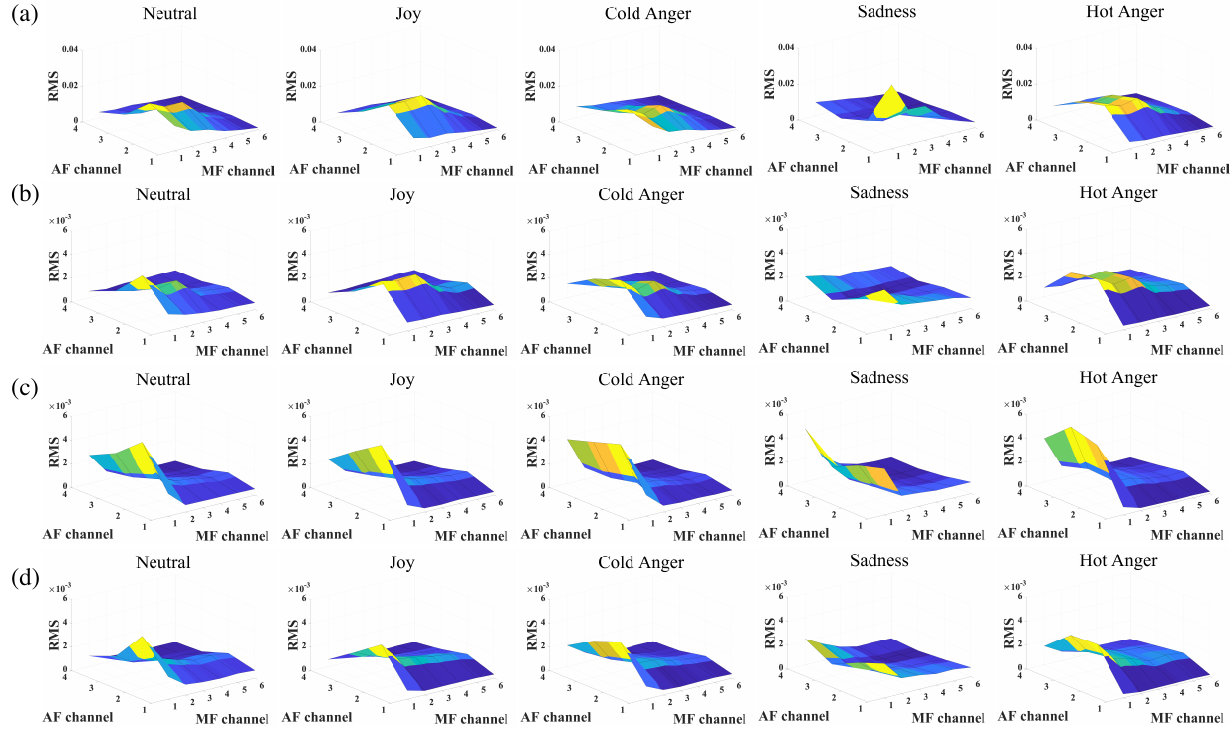
Figure 8. Time-average modulation representation in ( a ) a clean environment, ( b ) noisy environment (SNR = 5 dB), ( c ) reverberant environment ( T R = 1.0 s), and ( d ) noisy reverberant environment (SNR = 10 dB, T R = 0.5 s). MF channel denotes six modulation-frequency channels, AF channel denotes four acoustic-frequency